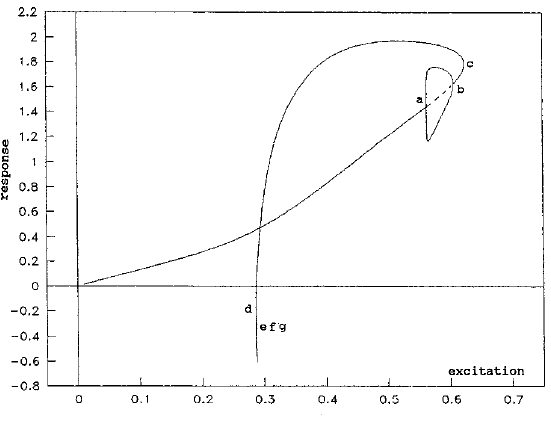
Fig. 4b. Period 8 bifurcation (lower